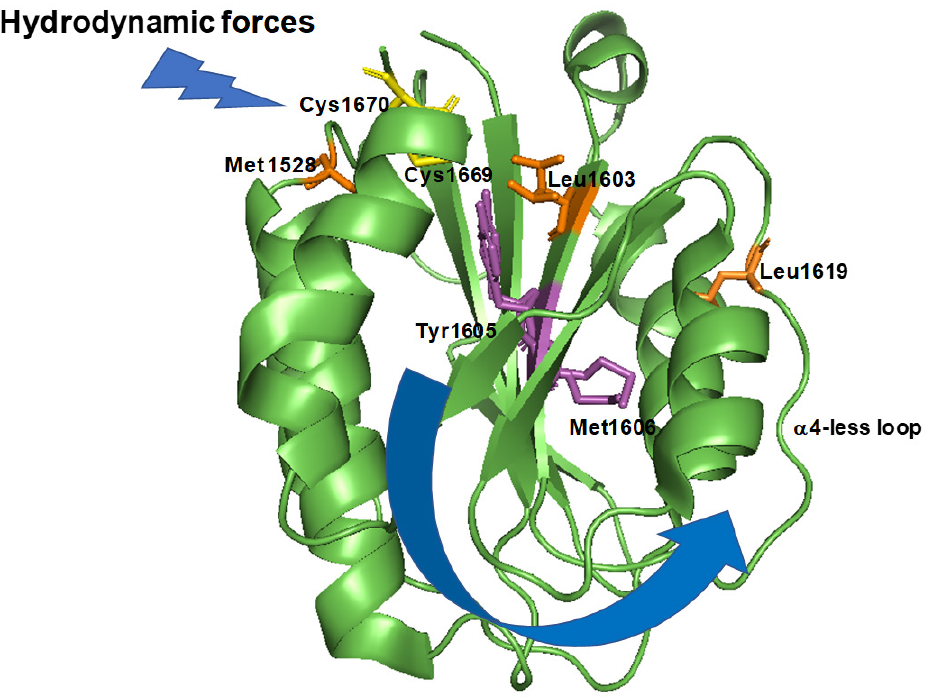
Figure 5: Effect of shear forces on the A2 domain of VWF. The A2 domain is shown in cartoon representation (PDB accession code 3gxb). As explained in the text, shear forces act on this domain and particularly on the 8-membered Cys1670-Cys1669 disulfide ring. The external hydrodynamic force acts primarily on this Cys1670-Cys1669 disulfide ring that represents a high energy barrier to the mechanical force. If the external force overcomes this energetic barrier, it will be transmitted to the hydrophobic core containing the Tyr1605-Met1606, via the apolar interactions of the vicinal Cys1670-Cys1669 ring with Leu1603 and Tyr1605. By virtue of this mechanical energy transfer, both the poor packing of the β4 strand and the high conformational flexibility of the long a4-less loop destabilize the hydrophobic core, which is solvated so that the Tyr1605-Met1606 peptide bond becomes available to proteolytic attack by ADAMTS-13. The conformational transition eliminates also the shielding effect of the A2 domain on the A1 domain that can bind to the platelet